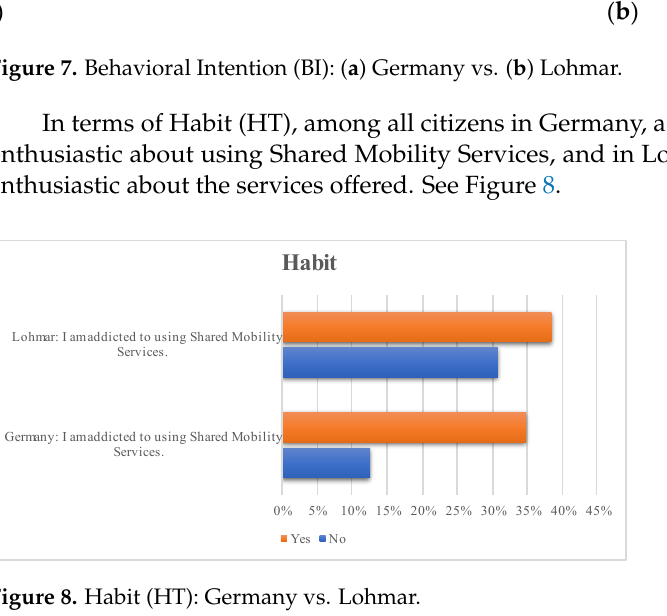
Figure 8. Habit (HT): Germany vs. Lohmar.